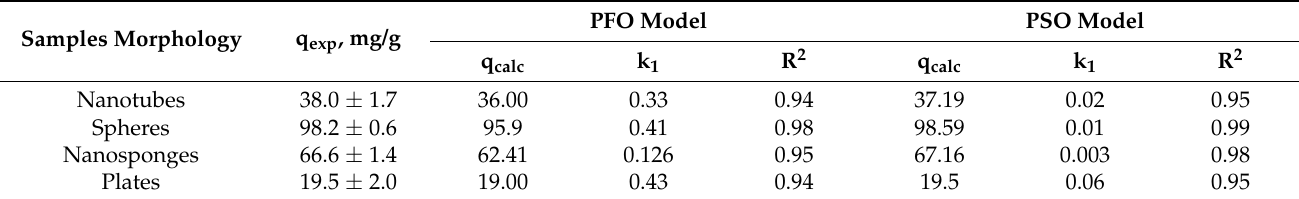
Table 4. The parameters of kinetic models of sorption of MB on aluminosilicates with different